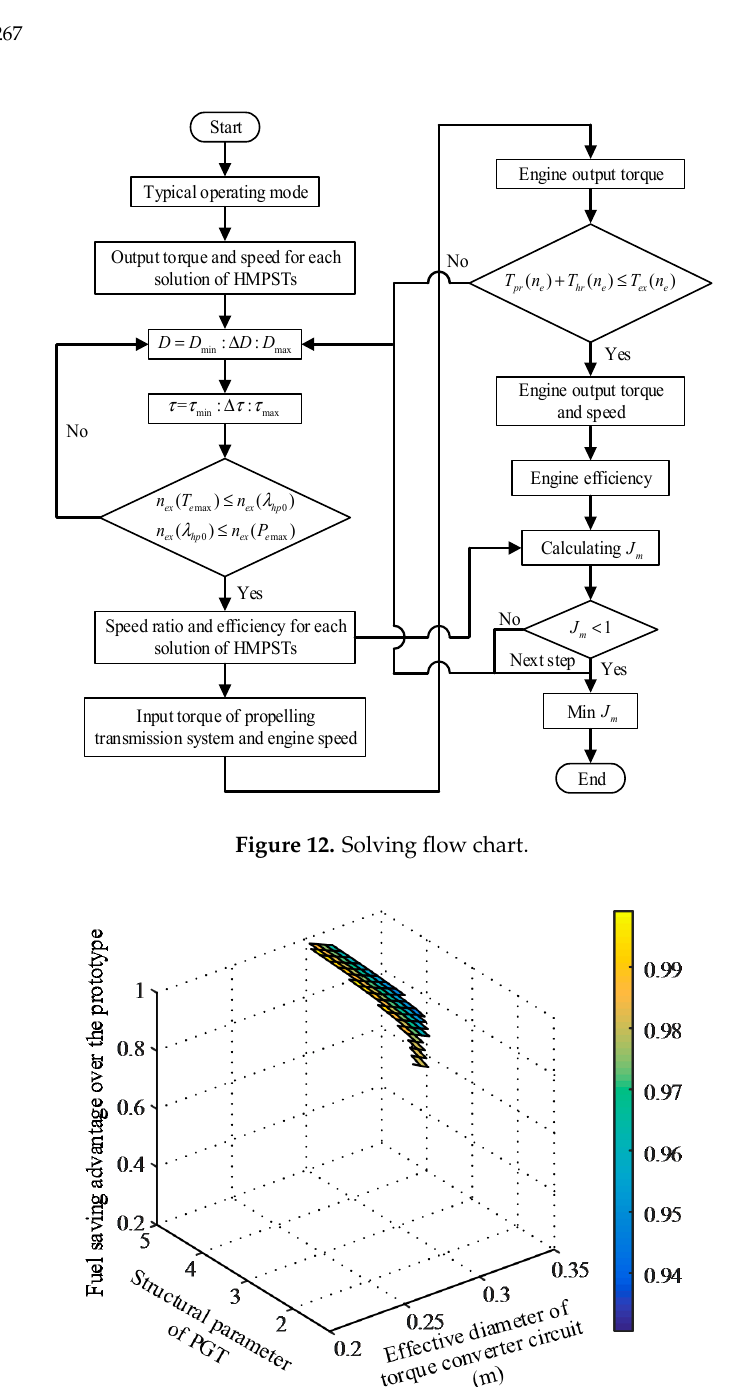
Figure 13. Solutions for scheme c .